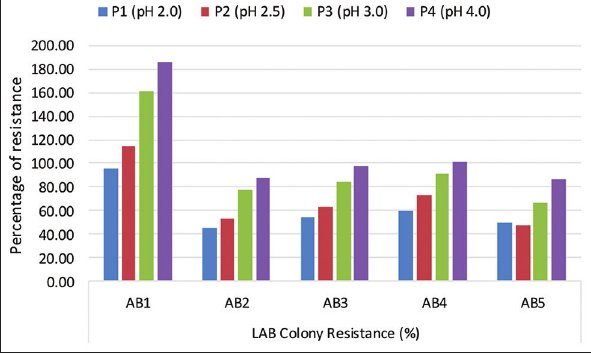
Figure-2: Percentage of five lactic acid bacteria isolates resistance at several acidic pH.